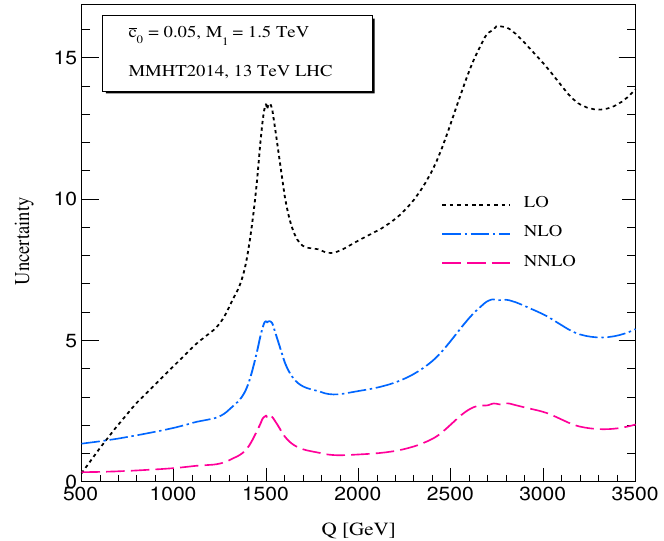
Figure 6 . 7-point scale variation in the signal is shown up to NNLO for the di-lepton invariant mass